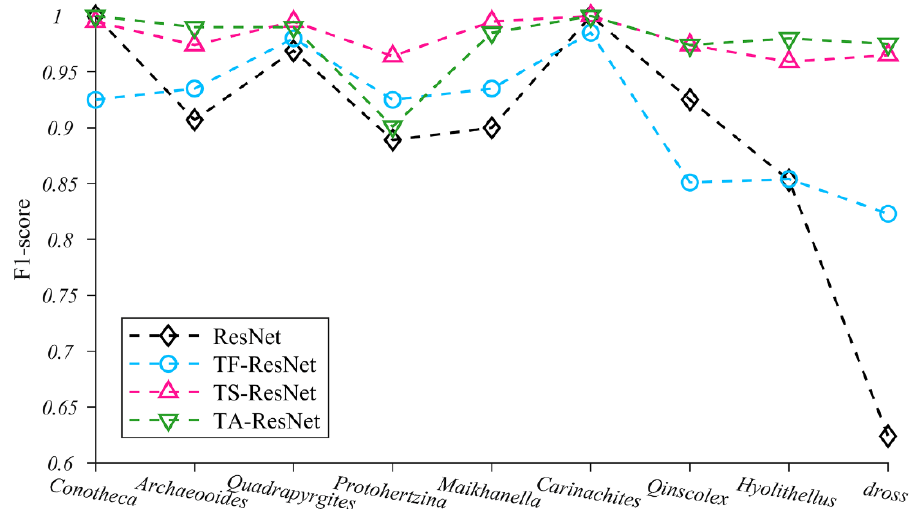
Figure 5. F1-score changes of nine microfossils using four training methods.